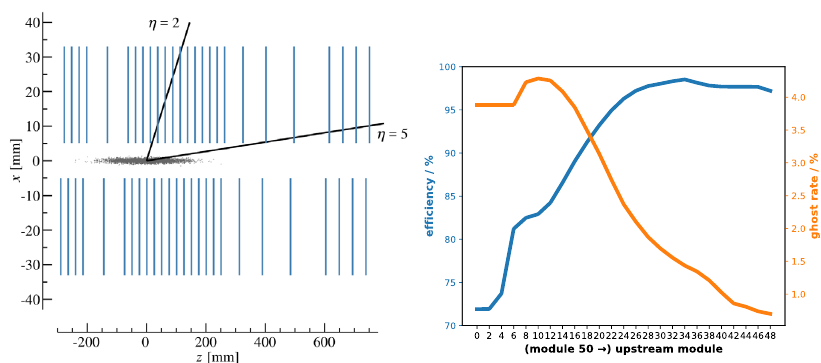
Figure 4: VELO planes and interaction region (left) and reconstruction quality